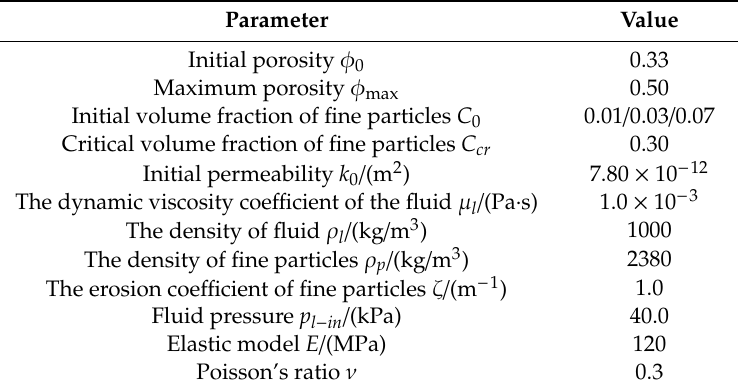
Table 2. Physical parameters for numerical calculation of subgrade